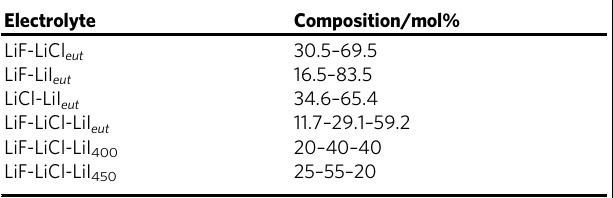
Table 1 Compositions of binary and ternary